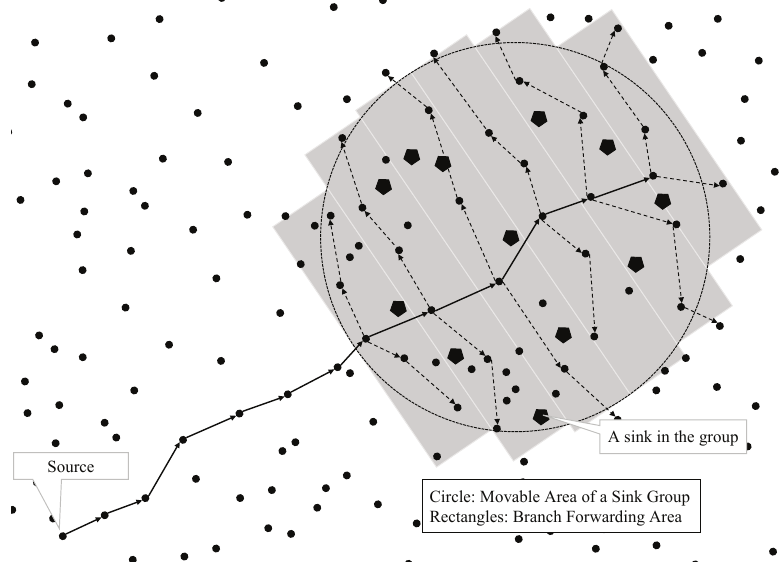
Figure 1. Overview of the proposed